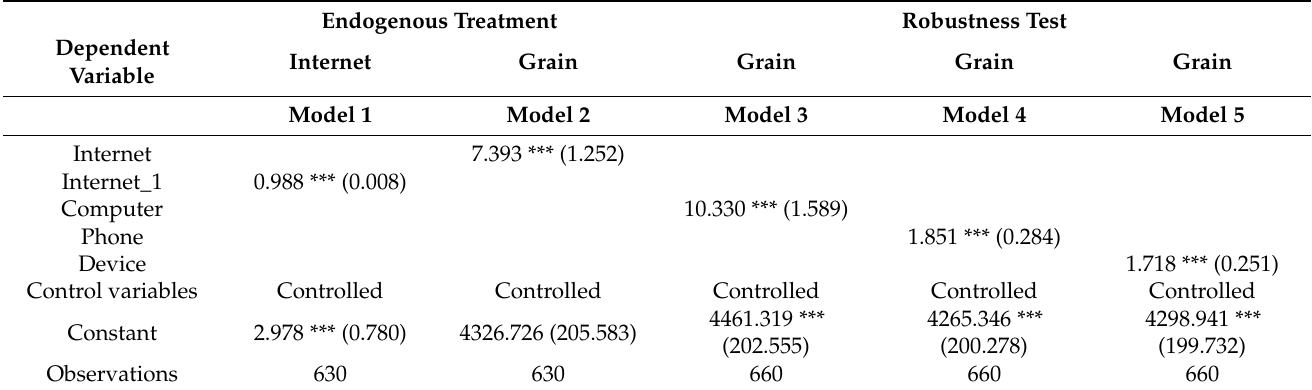
Table 5. Result of endogenous treatment and robustness